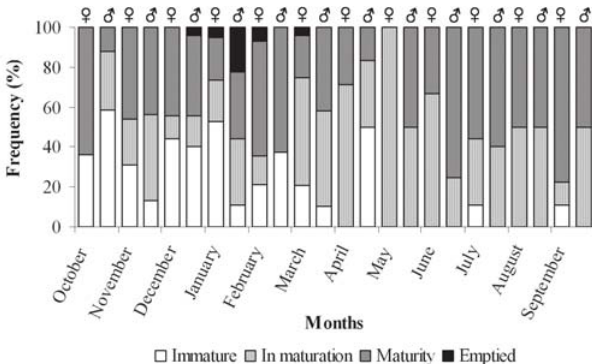
Fig. 6. Frequency of the reproductive stages found in each month to A . paranae in the Paulicéia stream.